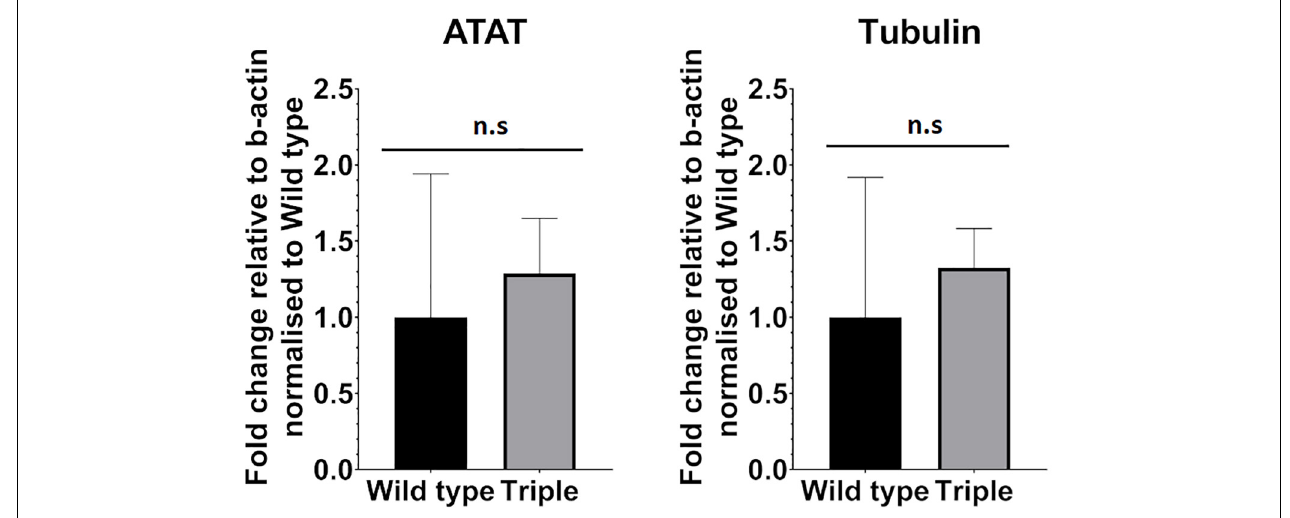
FIGURE 6 | ATAT-1 and Tubulin mRNA expression levels relative to b-actin expression in Wild type and triple mutants. ( n wt = 4 n tri = 6 mean with 95% CI.). ns, no